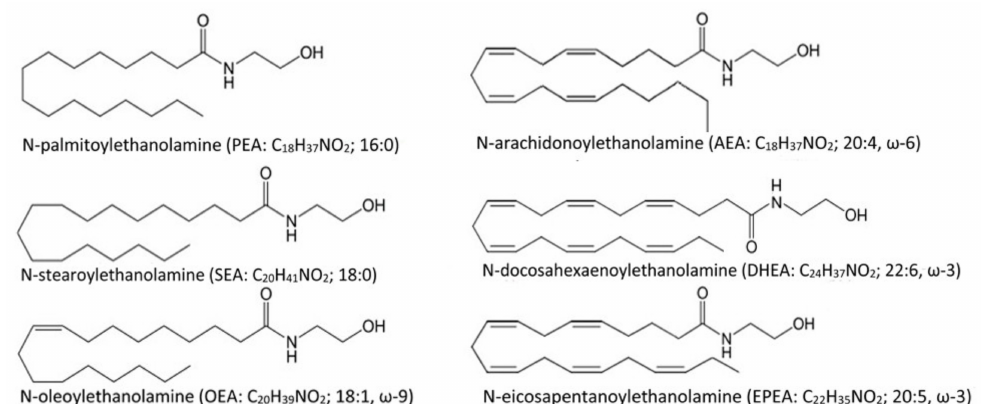
Figure 1. Fatty acid-derived N